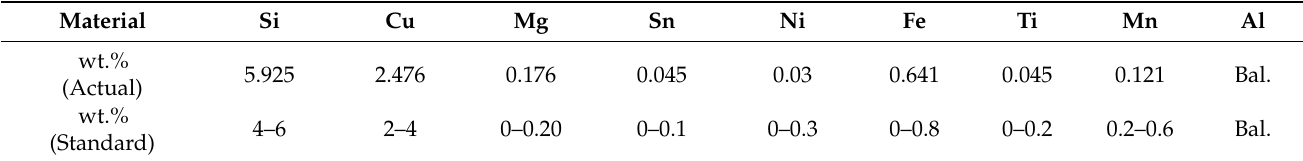
Table 1. Composition (wt.%) of LM4 alloy.